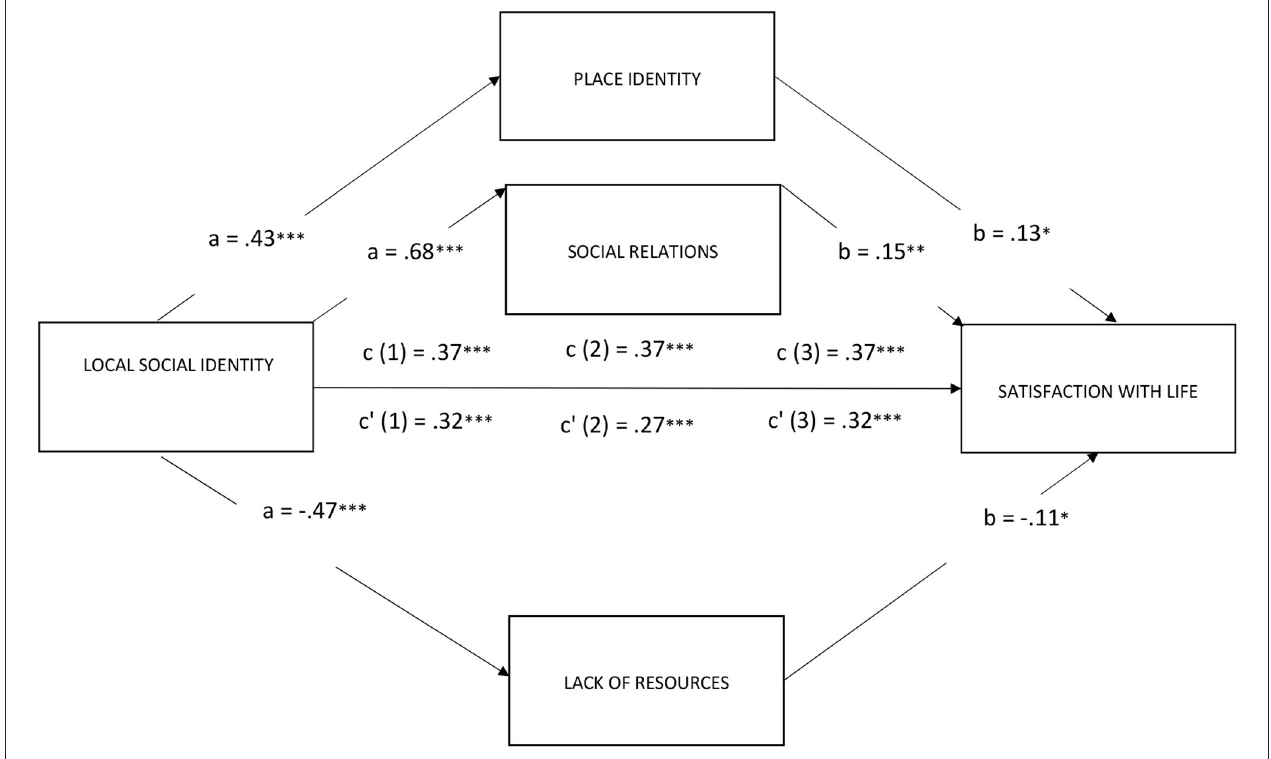
FIGURE 1 | Place identity, social relations, and lack of resources mediate the effect of local social identity on satisfaction with life (*** p < 0.001; ** p < 0.01; * p <